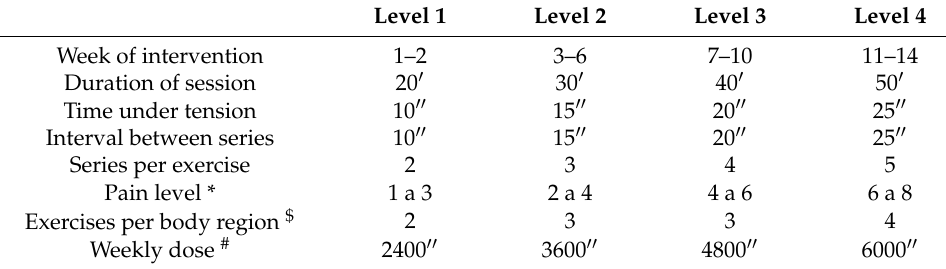
Table 1. Flexibility training protocol adopted in the